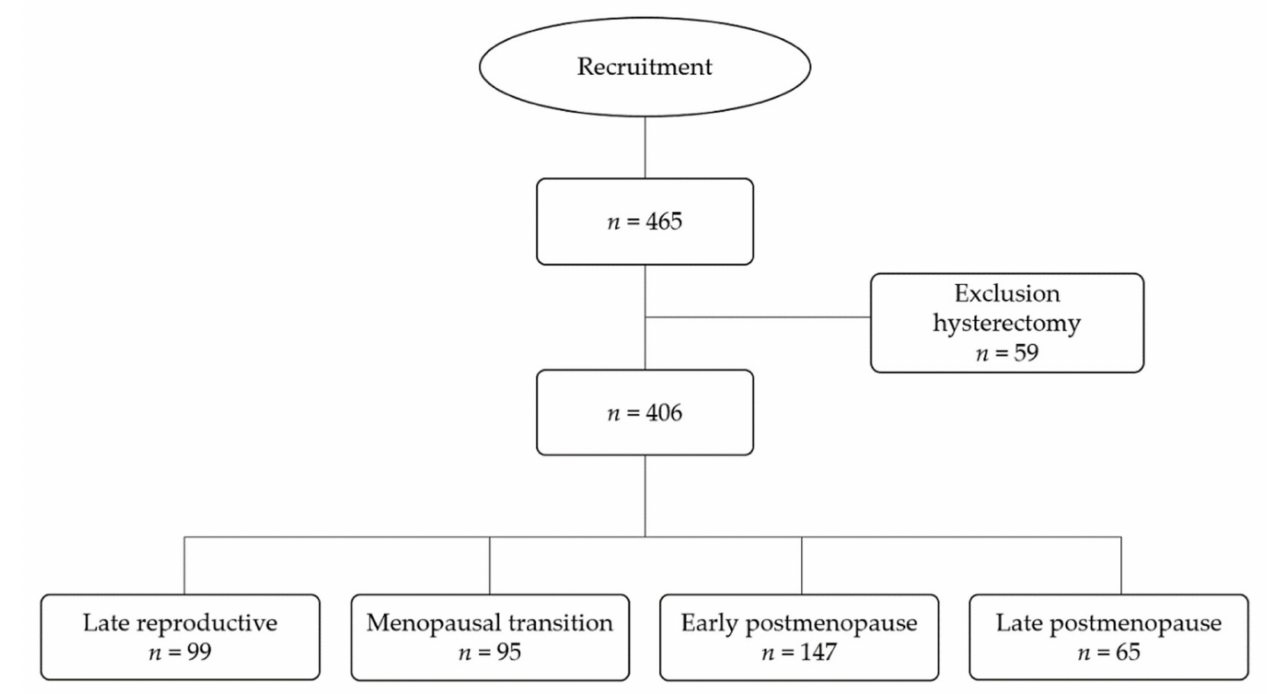
Figure 1. Flowchart of the recruitment of the study